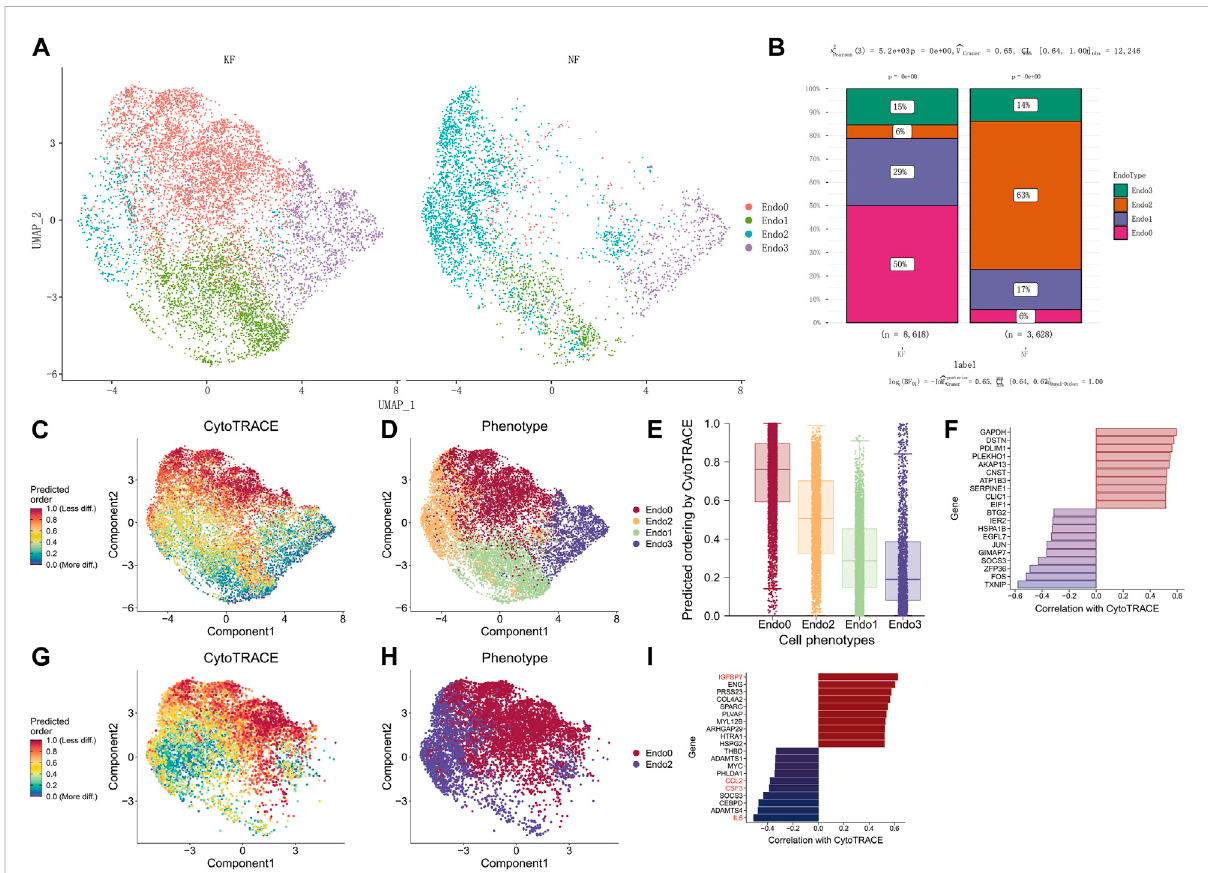
FIGURE 2 Endo2 differentiation to Endo0 is a major feature of keloidogenesis and development. (A) Differential cellular distribution of endothelial cells in NF and KF in the GSE163973 single-cell sequencing dataset. (B) Comparison of four subpopulations of NF and KF endothelial cells with a signi fi cant difference in the distribution of endothelial cells between the two (chi-square test, p < 0.001). (C – E) Differentiation trajectory of keloid endothelial cells. The lowest differentiation of Endo3 and the highest differentiation of Endo0 can be observed from the graph. (F) The major genes associated with endothelial cell differentiation. (G – I) Genes involved in the differentiation from Endo2 to Endo0. Genes including IL6, ADAMTS4, CEBPD, SOCS3, CSF3, and CCL2 inhibit endothelial cell differentiation, while genes such as IGFBP7, ENG, PRSS23, and COL4A2SPARC promote endothelial cell